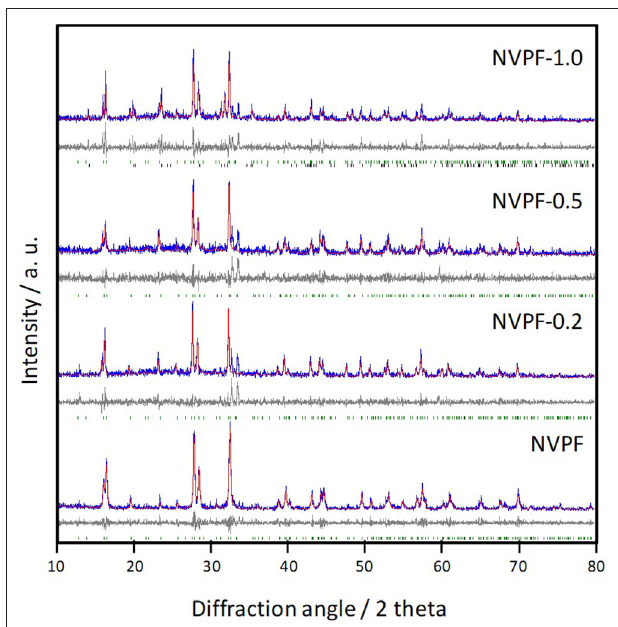
(gray) are included for each sample. DIF patterns for P4 2 /mnm and R-3c space groups are respectively displayed in green and black colors.